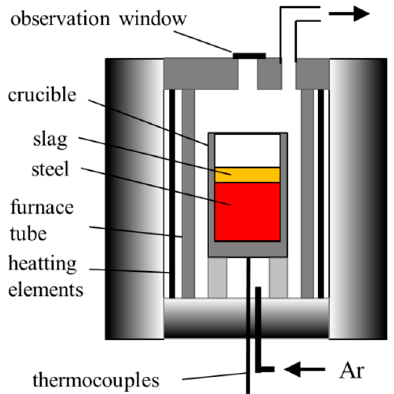
Figure 1. Schematic of experimental setup (Adapted from [18], with permission from John Wiley and Sons, 2020.). Table 1. Steel and slag information of experiments.